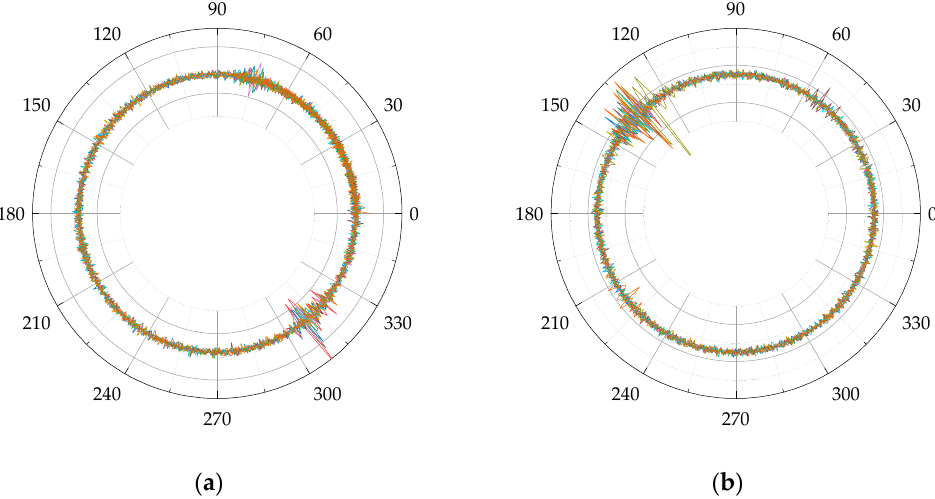
Figure 23. The deduced defect conditions of wheels: ( a ) Front wheel; ( b ) rear wheel.